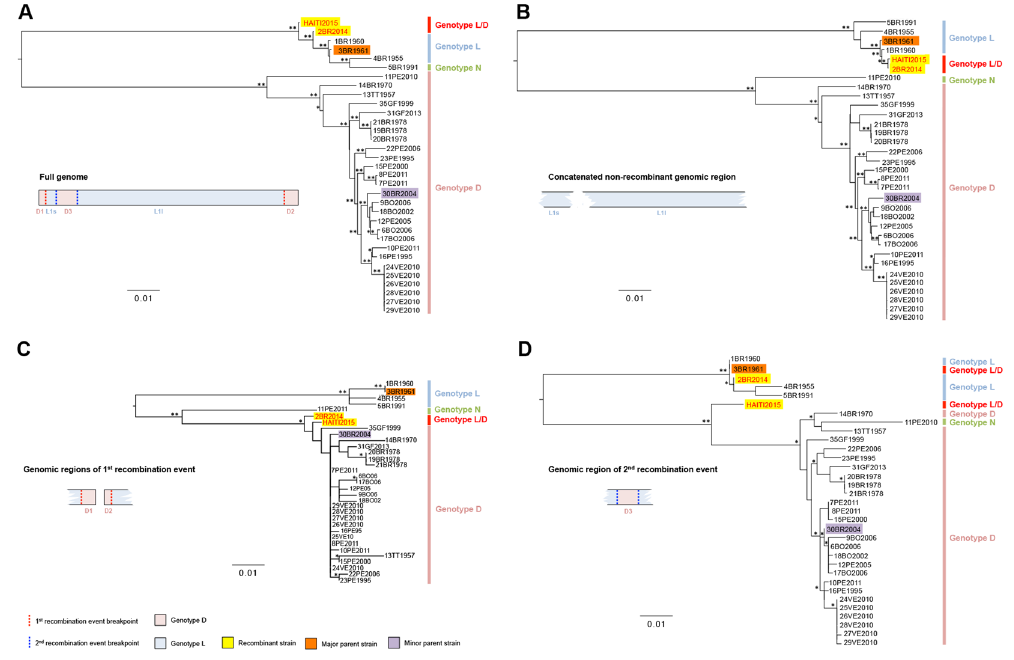
Figure 3. Maximum likelihood (ML) phylogenies of MAYV isolate full-genome, non-recombinant genomic fragment, and recombinant fragment sequences. ML trees were obtained for ( A ) full-genome, ( B ) non- recombinant genomic fragments, ( C ) recombinant fragments resulting from the first recombination event, and ( D ) recombinant fragments resulting from the second recombination event. The recombinant MAYV isolates are indicated by red lettering and highlighted in yellow, whereas the major and minor parental sequences are indicated by black lettering and highlighted in red and orange, respectively. ( * ) indicates strong statistical support along the branches defined by local or/and standard non-parametric bootstrap (BS) values > 75 or Shimodaira–Hasegawa-like approximate likelihood ratio test (SHa-LRT) > 95; ( ** ) indicates very strong statistical support defined by local or/and standard non-parametric BS > 75 and SHa-LRT > 99.